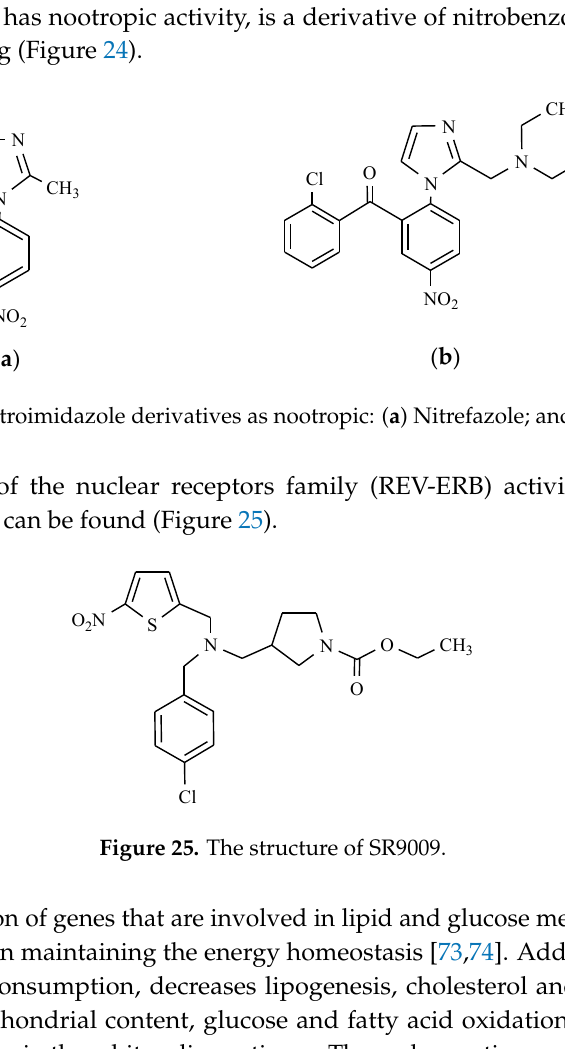
Figure 23. Nitromersol.